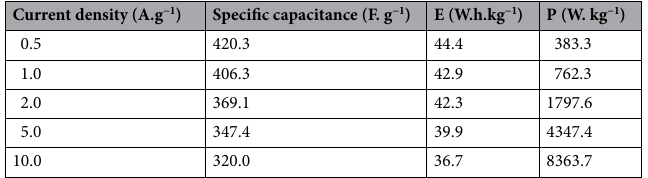
Table 2. Electroanalytical performance metrics of MWCNT/Ruthenium hydroxide aerogel-based supercapacitor.